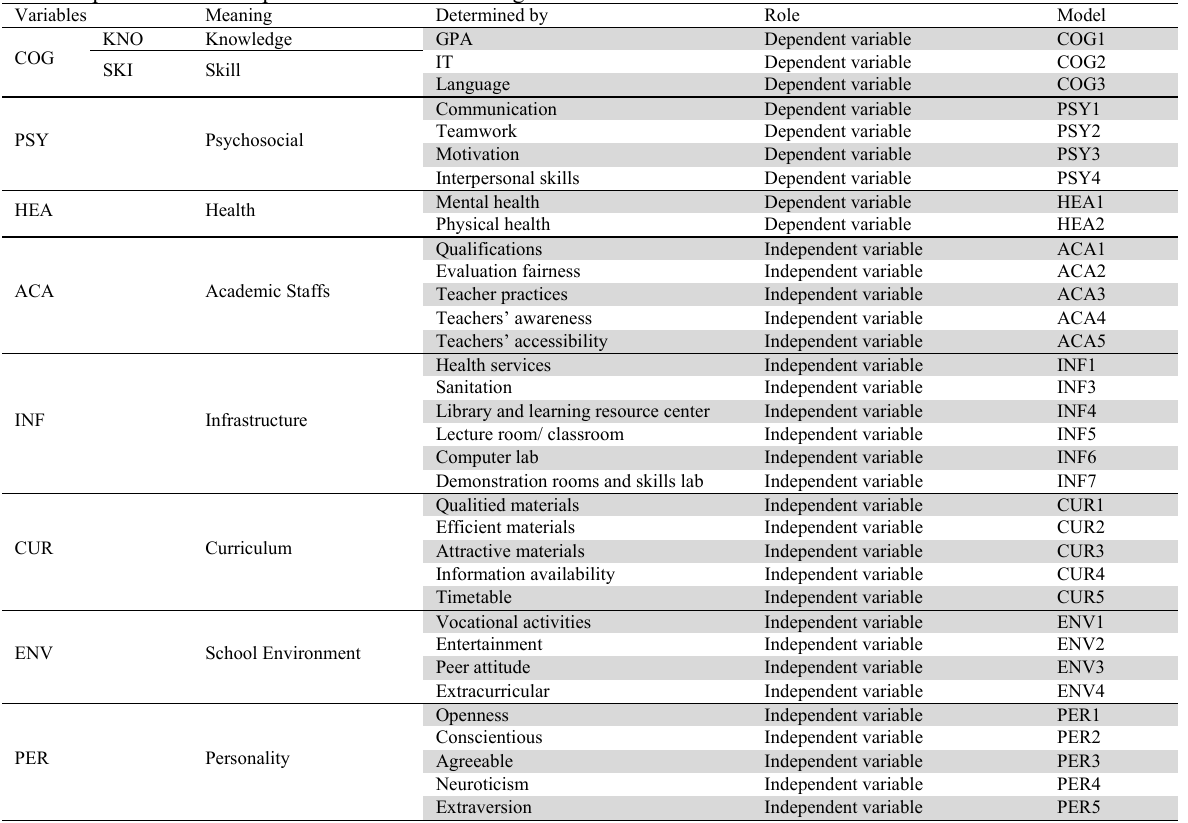
List of dependents and independent variables of the regression models